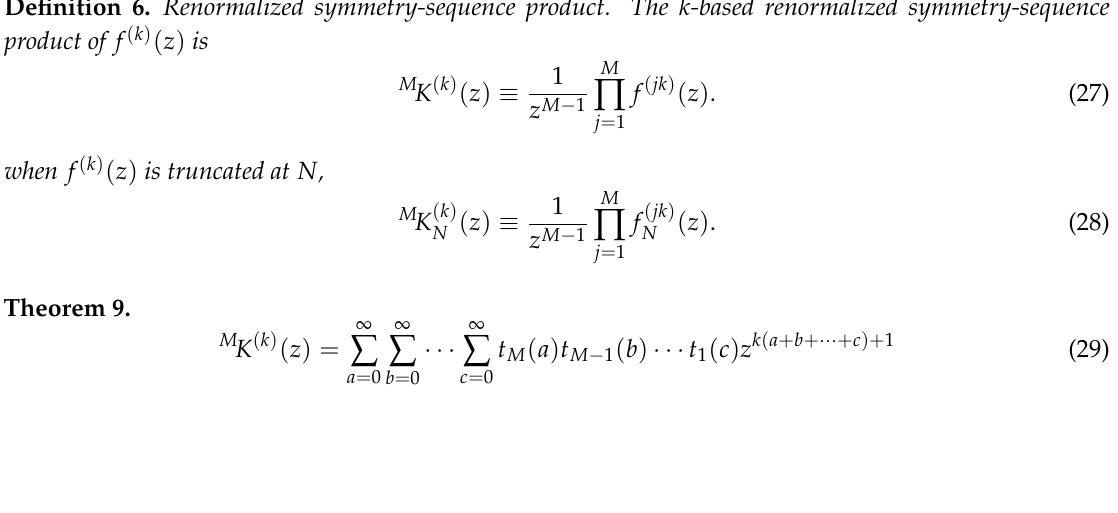
Figure 7. Renormalized powers (first, j = 1, to sixth, j = 6) of j R Three-fold symmetry is maintained the function narrows in towards the symmetry axes as the power increase, i.e., the convexity of the main unity contour is